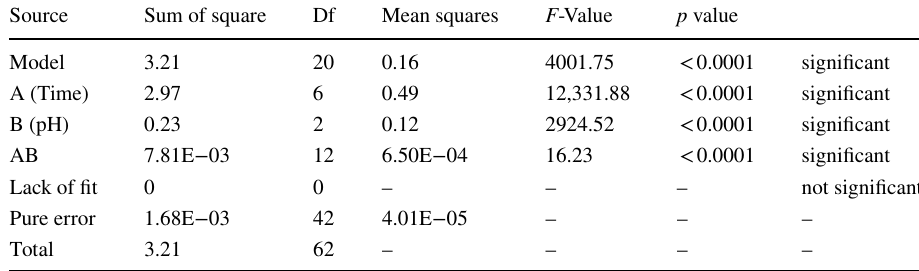
Table 1 Analysis of variance for MO destruction rate by